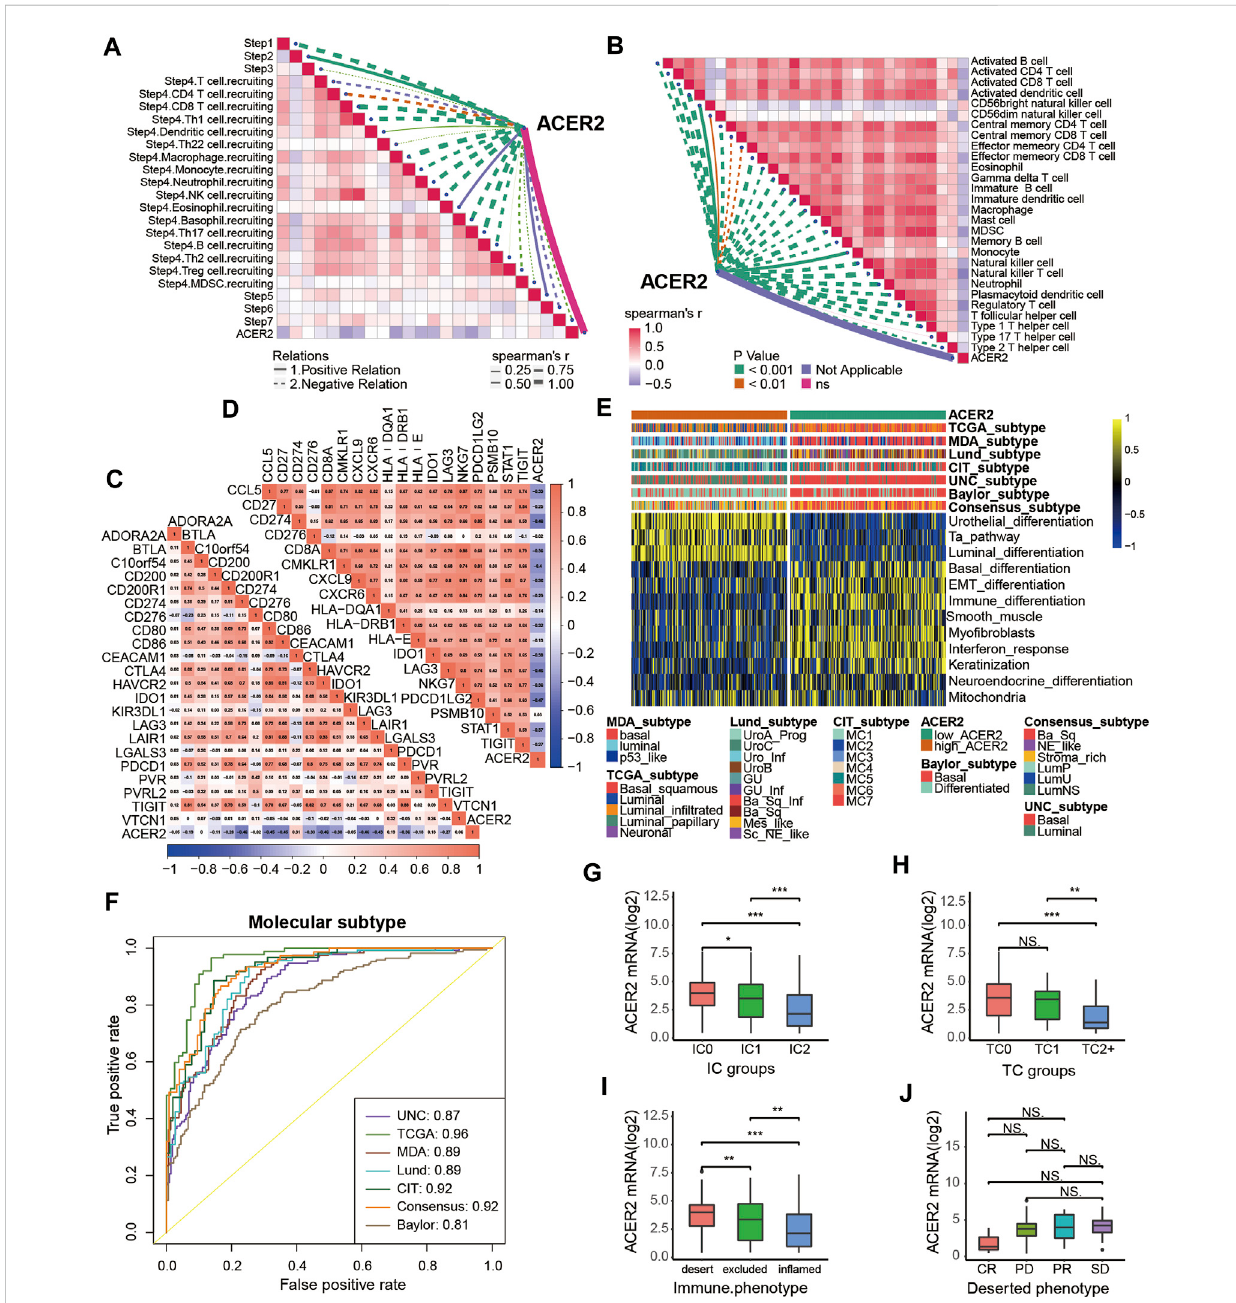
FIGURE 6 Validation of the ACER2 prediction for low immune in fi ltration and molecular subtypes in the IMvigor210. (A) Correlation between ACER2 and the process of the anti-cancer immunity cycle. (B) Correlation between ACER2 and several immune-related cells. (C) Correlation between ACER2 and ICI effector genes. (D) Correlation between ACER2 and TIS-related genes. (E, F) Correlations between ACER2 and seven molecular subtype systems and corresponding ROC analysis for prediction accuracy. (G) Differential expression of ACER2 in different IC groups. (H) Differential expression of ACER2 in different TC groups. (I) Differential expression of ACER2 in three immune phenotypes (the desert, excluded, and in fl amed). (J) Correlation between ACER2 and the clinical response of tumor immunotherapy in the desert